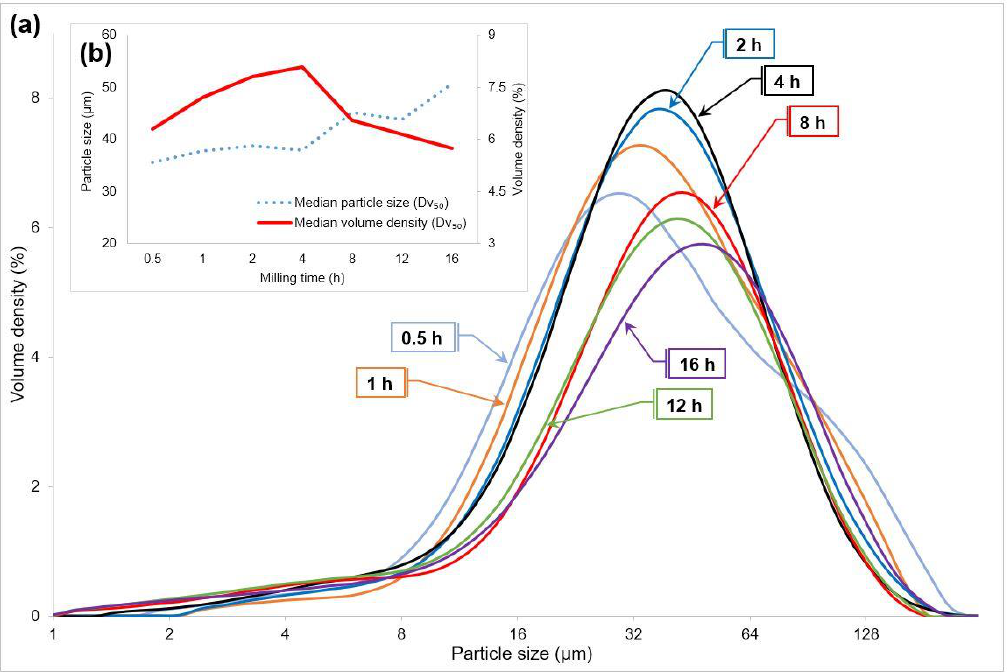
Figure 5. The plot of ( a ) PSD and ( b ) median values of milled composites from 0.5 to 16 h.